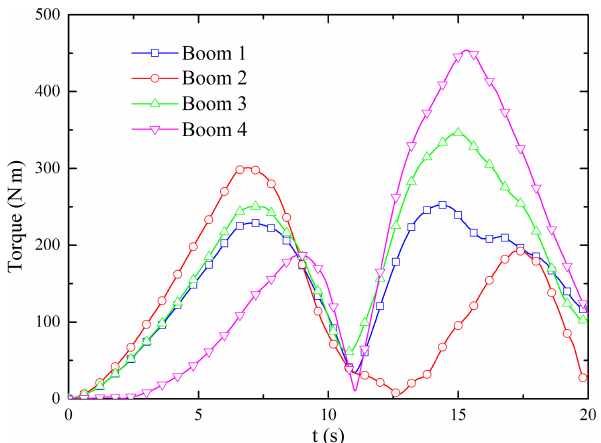
Figure 11. Control torque without a filter.